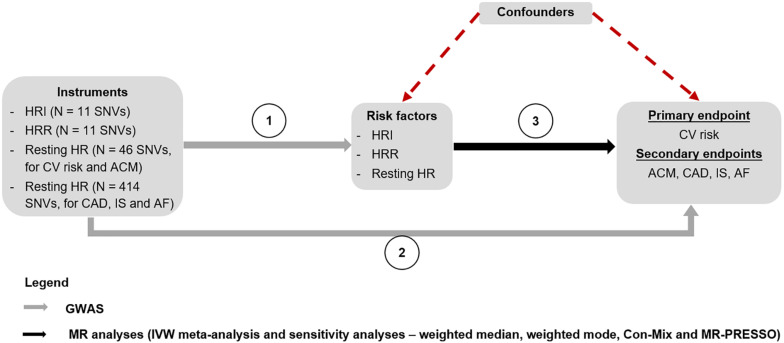
MR study design. The genetic associations of the instruments for HRI, HRR, and resting HR were derived from the GWASs performed by Eppinga et al. (2016), Ramírez et al. (2018), Verweij et al. (2018), and an internal GWAS on resting HR using the entire UK Biobank population, respectively (Step 1). A lookup of these instruments was performed in GWASs for CV events and ACM conducted in the UK Biobank population, to find the genetic associations with these two outcomes. The genetic associations of the instruments with CAD (Nelson et al., 2017), IS (Malik et al., 2018), and AF (Nielsen et al., 2018) were derived by conducting a lookup of the SNVs in the respective GWAS summary statistics for each outcome (Step 2). Finally, MR analyses were conducted to estimate the causal associations between HRI, HRR, and resting HR, and each of the outcomes using an IVW meta-analysis, as well as sensitivity analyses (Step 3). ACM, all-cause mortality; AF, atrial fibrillation; CAD, coronary artery disease; Con-Mix, contamination mixture; CV, cardiovascular; GWAS, genome-wide association study; HR, heart rate; HRI, heart rate increase; HRR, heart rate recovery; IS, ischemic stroke; IVW, inverse variance weighted; MR, Mendelian randomization; SNV, single-nucleotide variant.